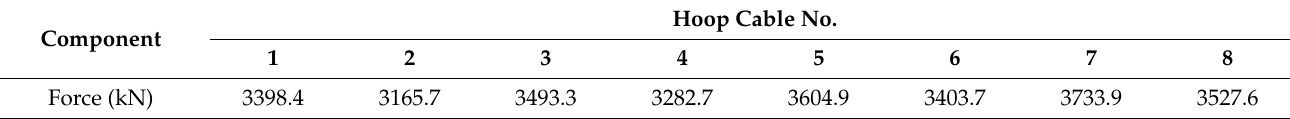
Figure 9. Axial force in V column outer branches after force-finding analysis.